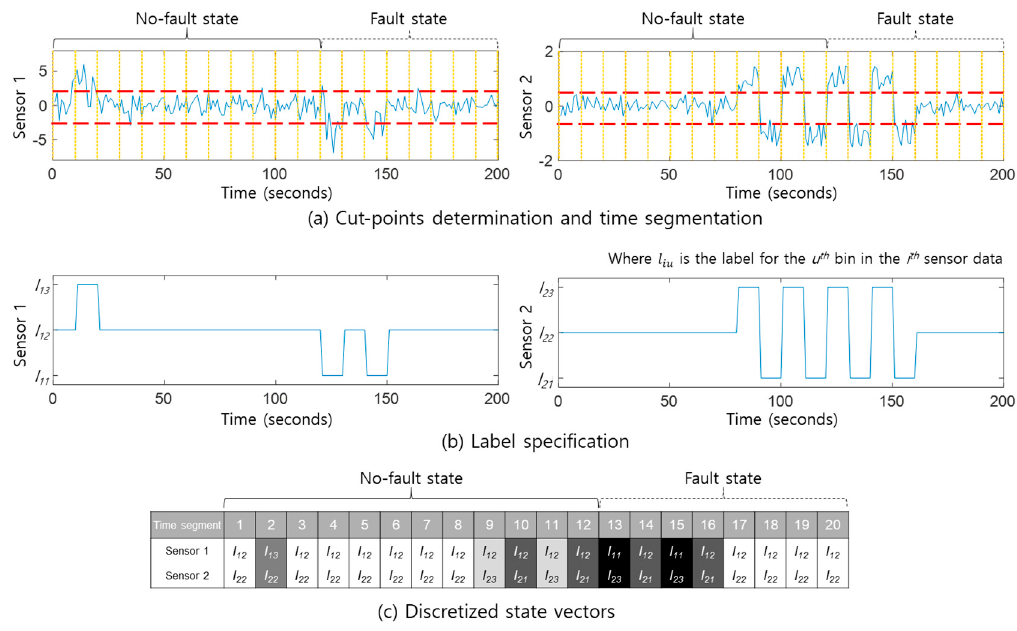
Figure 2. Transformation of multi-sensor signals to a series of discretized state vectors [19].